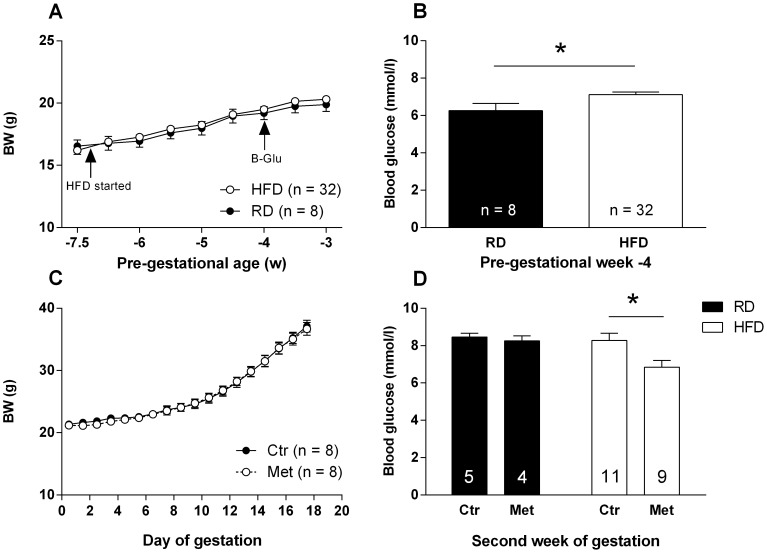
The effect of HFD and metformin treatment on the metabolism of the dams.Body weight during pre-gestational HFD period (A). Fasting blood glucose after three weeks of HFD consumption (B). Body weight development during E0.5–17.5 (C). Blood glucose on the second week (E11.5–12.5) of the gestation (D). * = P<0.05 by Student's t-test.